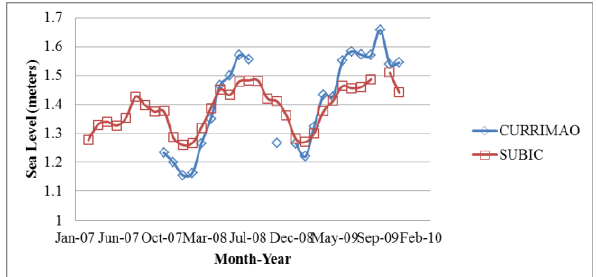
Figure 5. Monthly sea level records at the Currimao, Ilocos Norte and Subic Bay, Zambales